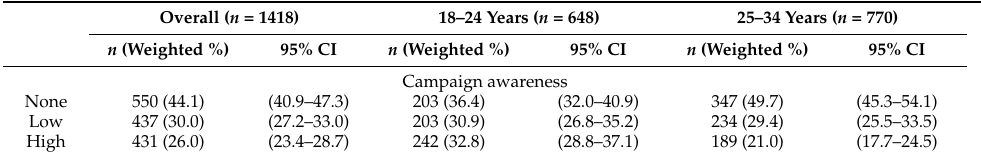
Table 2. Campaign awareness overall and by age